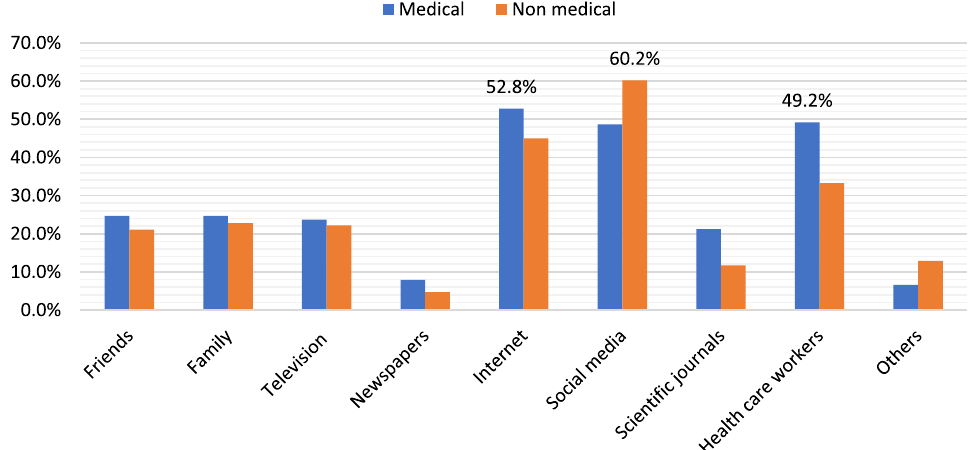
Fig. 3 Sources of information about COVID-19 vaccine among medical and non-medical university students